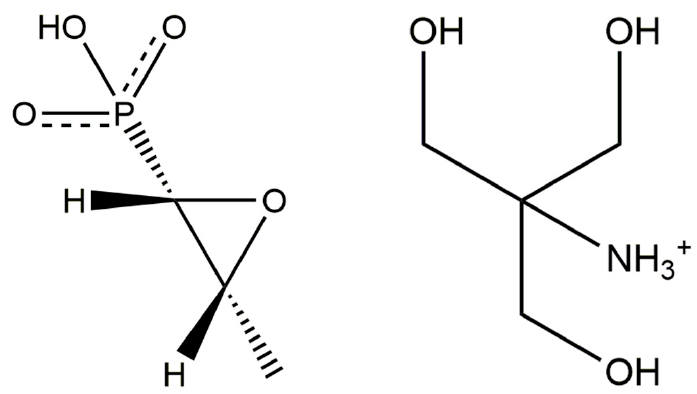
Figure 1. The molecular structure of fosfomycin tromethamine.